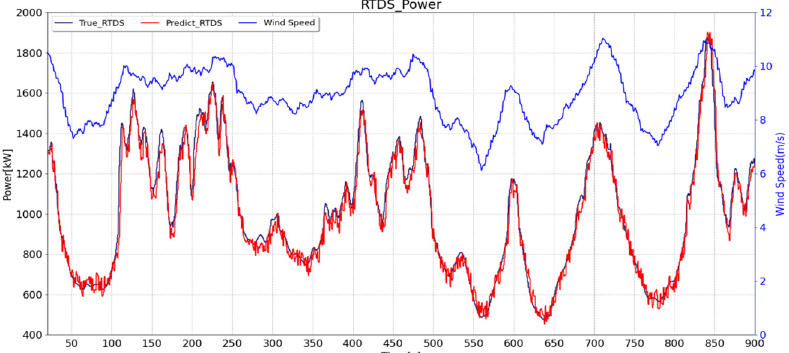
Figure 10. Comparison of power generation using